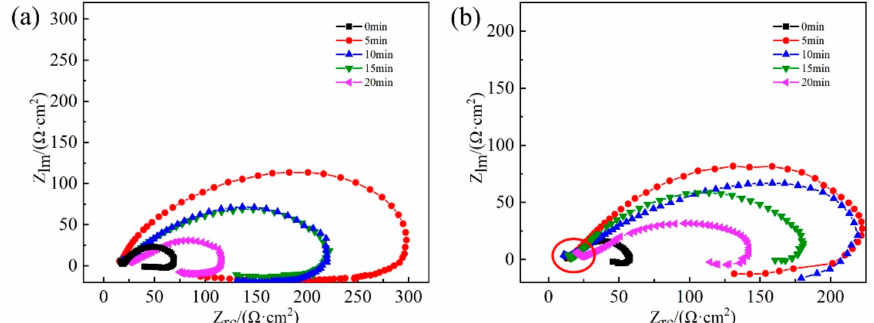
Figure 6. The e ff ect of the RASP-processed time on the Nyquist plots of the SA106B low-carbon steel measured at open-circuit potential with a sinusoidal potential amplitude of 10 mV, running from 100 kHz to 10 MHz in the ( a ) 0.05 M H 2 SO 4 + 0.05 M Na 2 SO 4 solution and ( b ) 0.2 M NaCl + 0.05 M Na 2 SO 4 solution at room temperature.